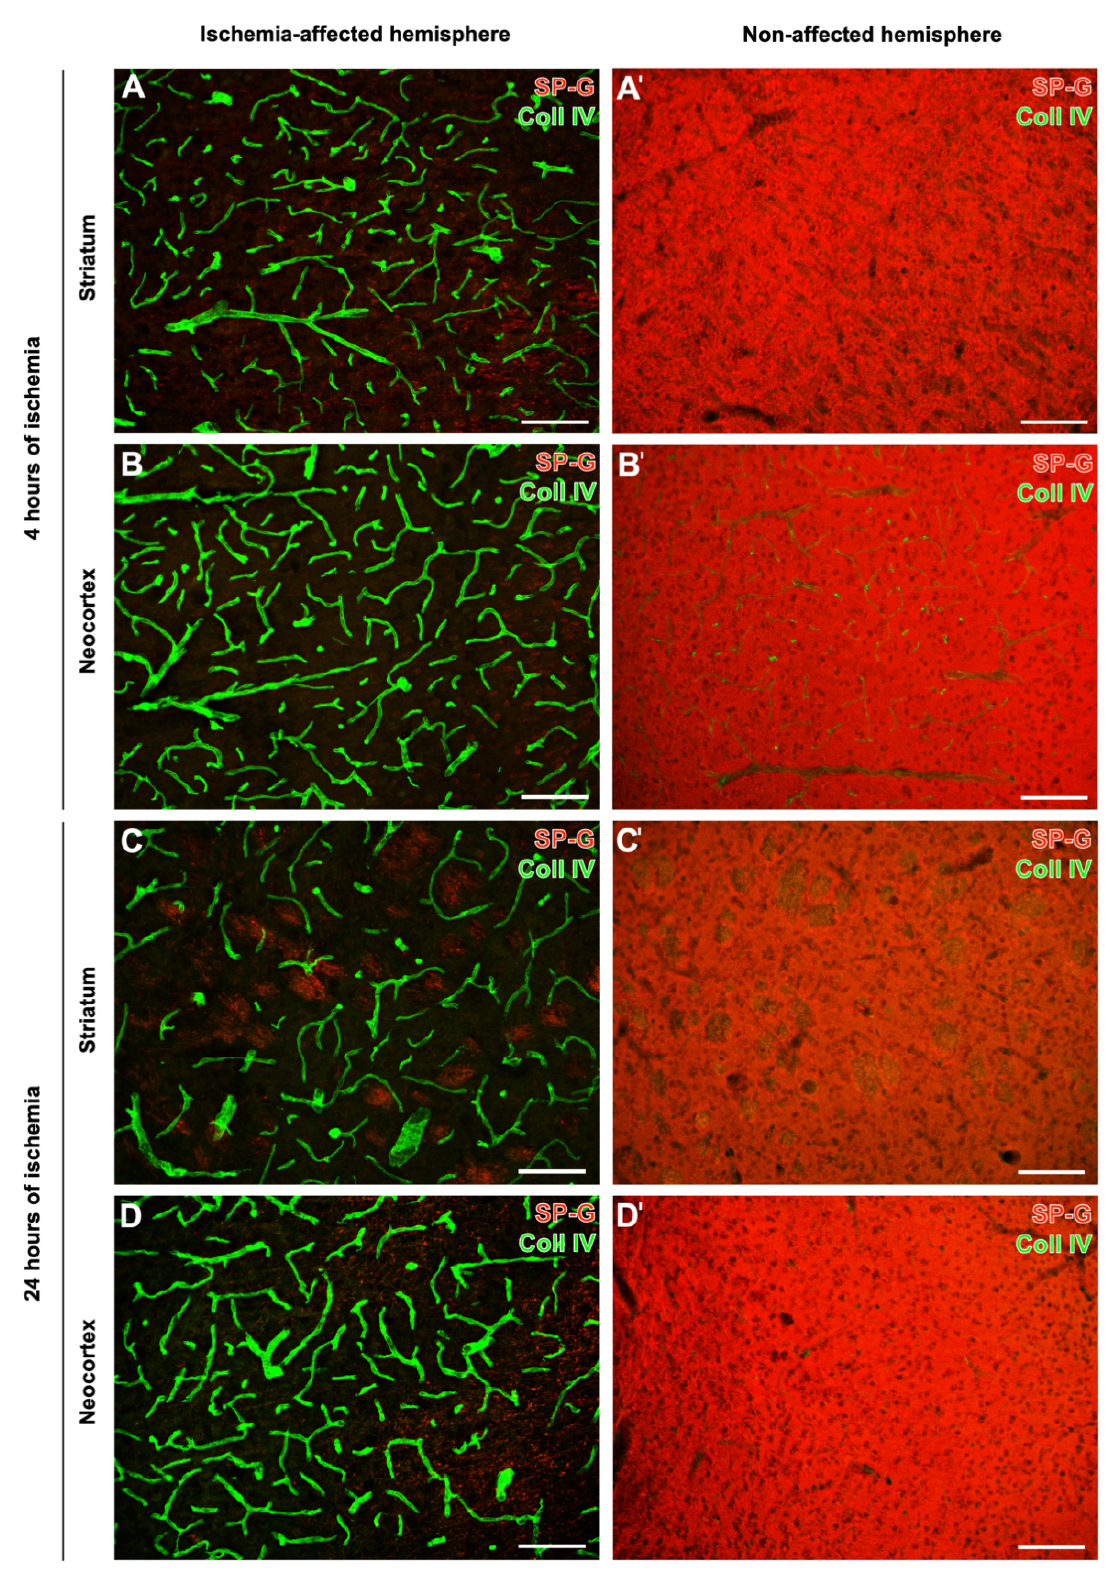
Figure 4. Surfactant protein-G (SP-G) and vascular elements after 4 h or 24 h of ischemia in mice depending on brain regions. Exemplary double fluorescence labeling of SP-G and collagen IV (Coll IV) in the affected and non-affected neocortex ( B , B’ , D , D’ ) and the affected and non-affected striatum ( A , A’ , C , C’ ) of mice subjected to 4 h or 24 h of focal cerebral ischemia. Scale bars: all = 100 µ m. Quantitative analyses were performed to confirm the observed ischemia-associated alterations of SP-G and associated vascular elements. In addition to SP-G, collagen IV was chosen as the most robustly affected marker in the qualitative analyses. For this purpose, 7 regions of interest (ROIs) were positioned at the ischemia-affected hemisphere and were